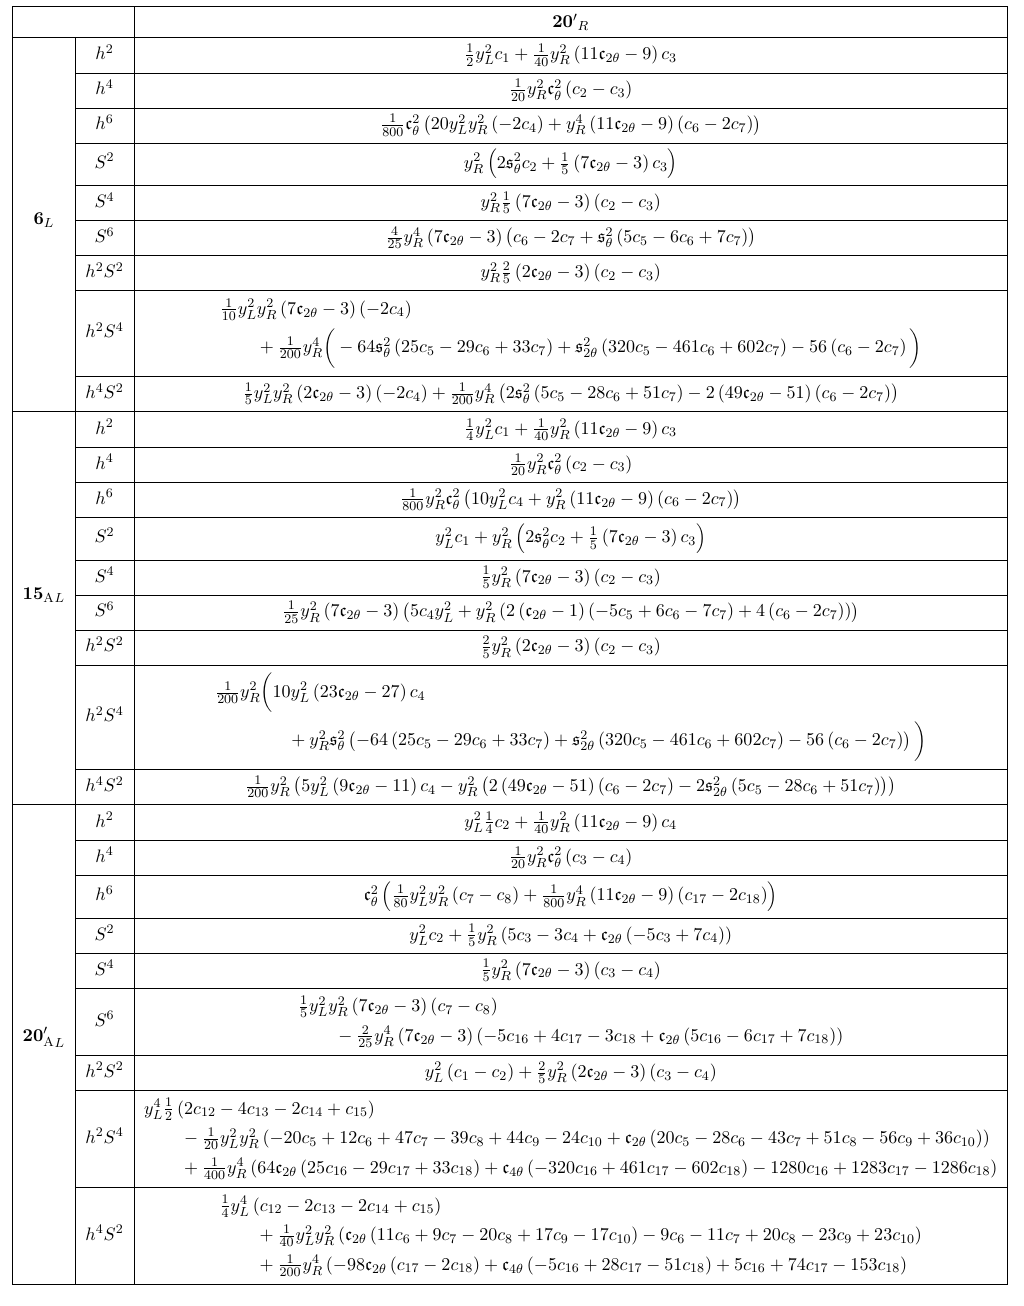
Table 4 . V ( h, S ) terms obtained via our spurion analysis for t R in a 20 0 of SO(6) ( θ 20 R 2 = AB 0) . This configuration is chosen in order to reproduce a heavy top quark and simultaneously a CPV-inducing term, combining viably with the 20 0 such as to generate a S 6 term at NLO and A L fitting our SNR criteria. Only leading terms are shown and each entry should be multiplied by N c m 4 / 16 π 2 , while every h or S comes with a factor 1 /f and every y L,R with a 1 /g ∗ . Parameters ∗ that contribute in the same way in the given approximation were collected into single c i and we abbreviate c 2 θ = cos 2 θ 20R1 and s 2 = sin 2 θ 20R1 , while θ 15 L , θ 20 L = 0 . The smaller left-handed θ embeddings do not fit the SNR coupling pattern in this choice of angles — for a discussion of nonzero θ 20 R 2 , which does allow SNR also in those cases, see main